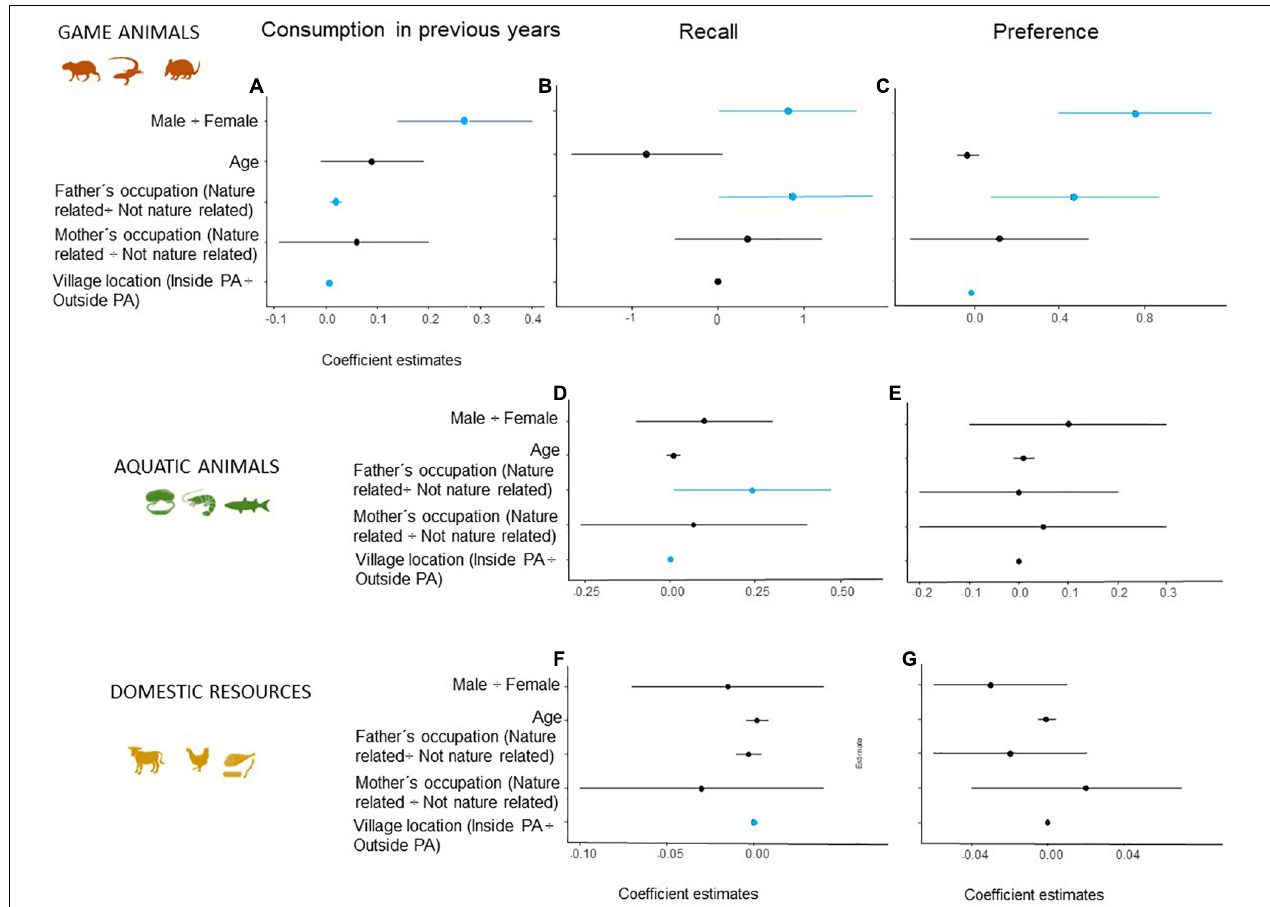
FIGURE 3 | Generalized linear mixed models (GLMMs) to evaluate consumption in previous weeks, consumption the day before the interview (24-h recall), and preference for game resources ( A–C , respectively), aquatic wildlife (D,E) , and domestic sources of meat (F,G) . Coefficient estimates ( ± 95% confidence interval) show how social factors modulate (direction and magnitude) consumption of game. Black and blue dots represent, respectively, the absence of significant effect and significant positive effect in the response